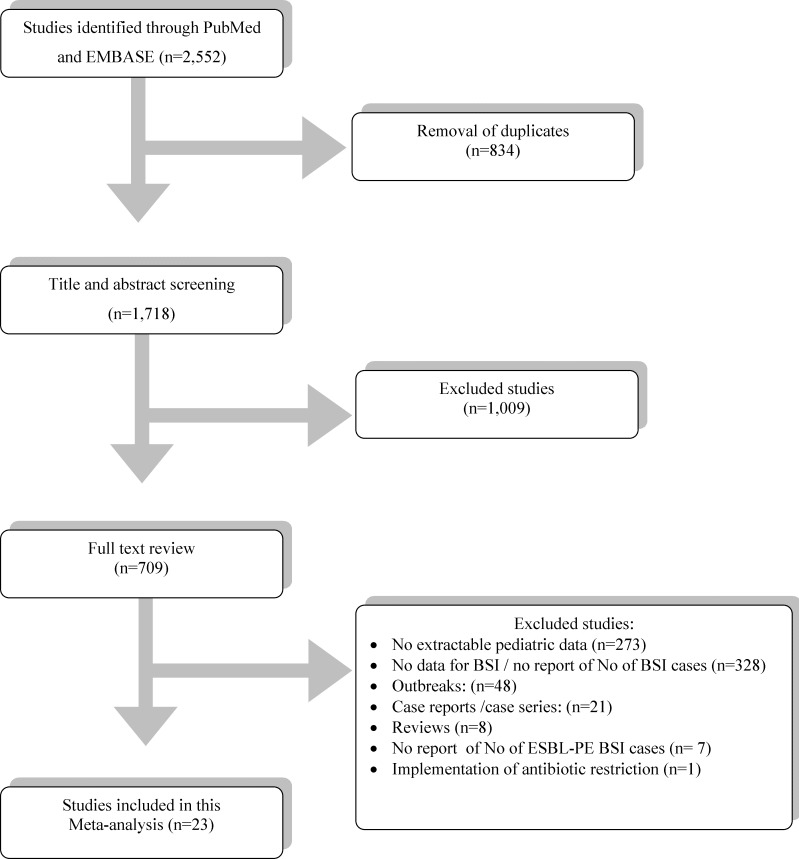
PRISMA flow diagram.